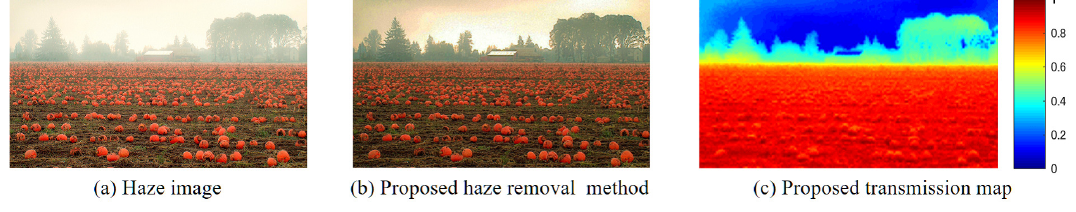
Figure 1. Examples of original haze image and proposed haze-removal image and transmission map ( γ =